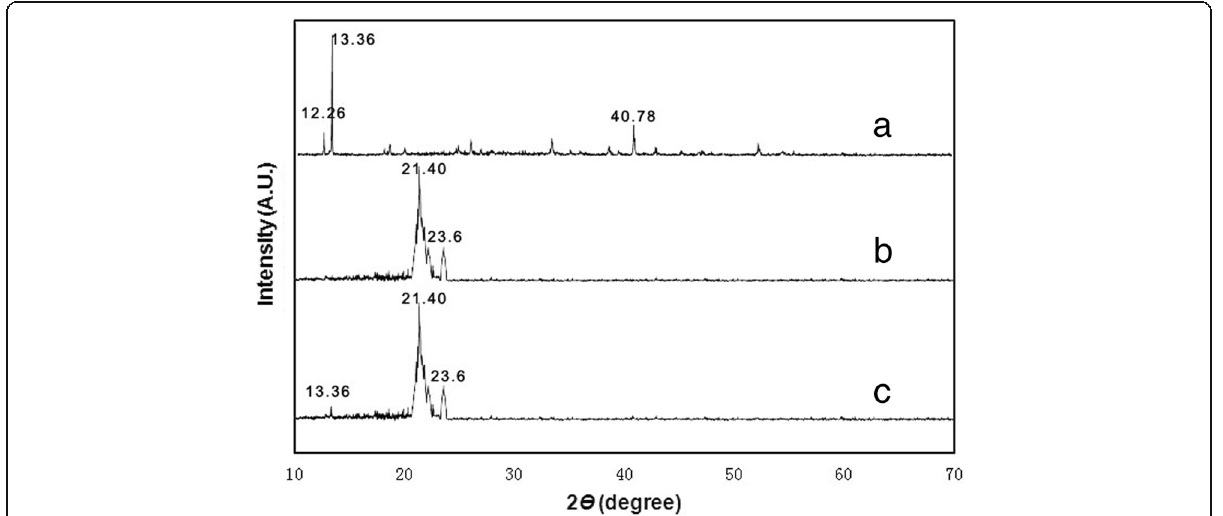
Fig. 3 XRD patterns. a Cis -DIDP powders. b PCL fibers. c Cis -DIDP@PCL fibers